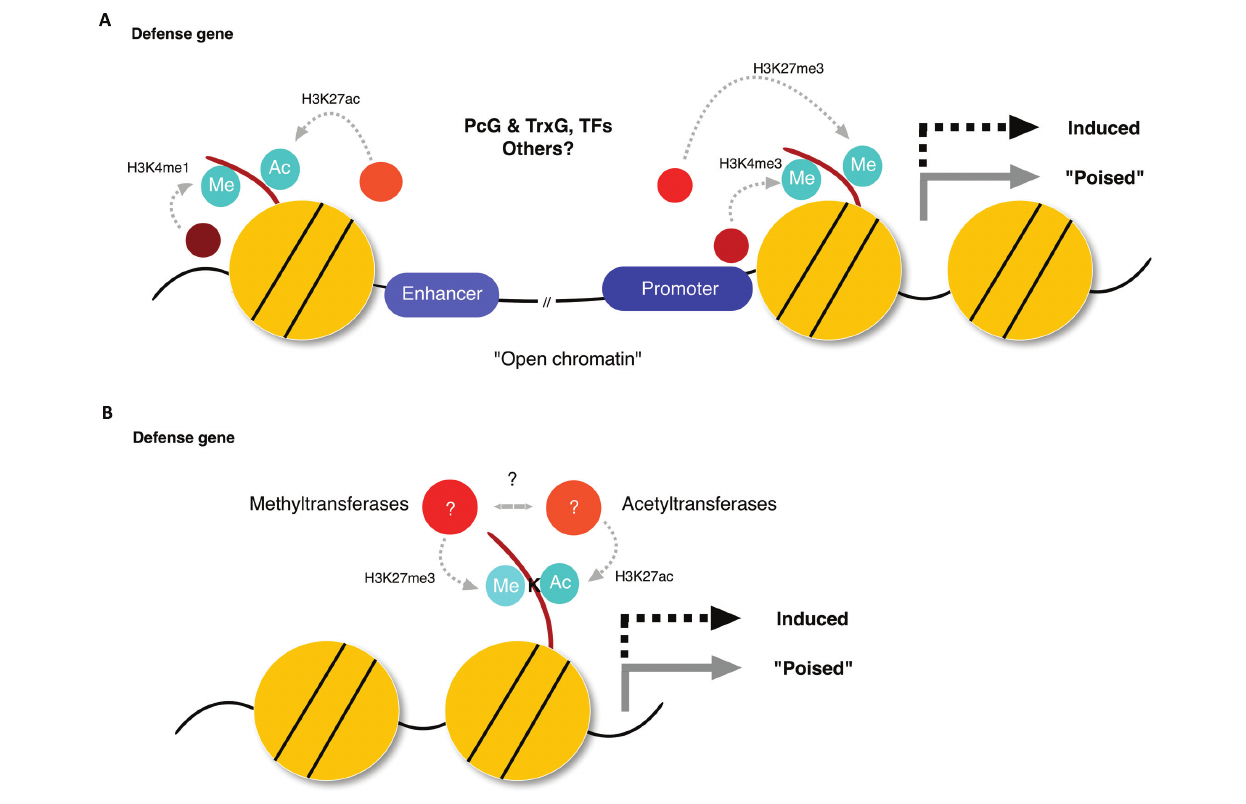
FIGURE 2 | Bivalent phenomena hypothesis in plant defense priming. (A) An interplay of opposing histone modification marks in enhancer and promoter regions modulate the expression status of defense-related genes. Polycomb-group (PcG) and Trithorax (TrxG) proteins may assemble with interacting proteins, such as transcription factors (TFs). (B) Opposing histone marks on the same lysine-site ( K -site) act as a switch to modulate the expression status of defense-related